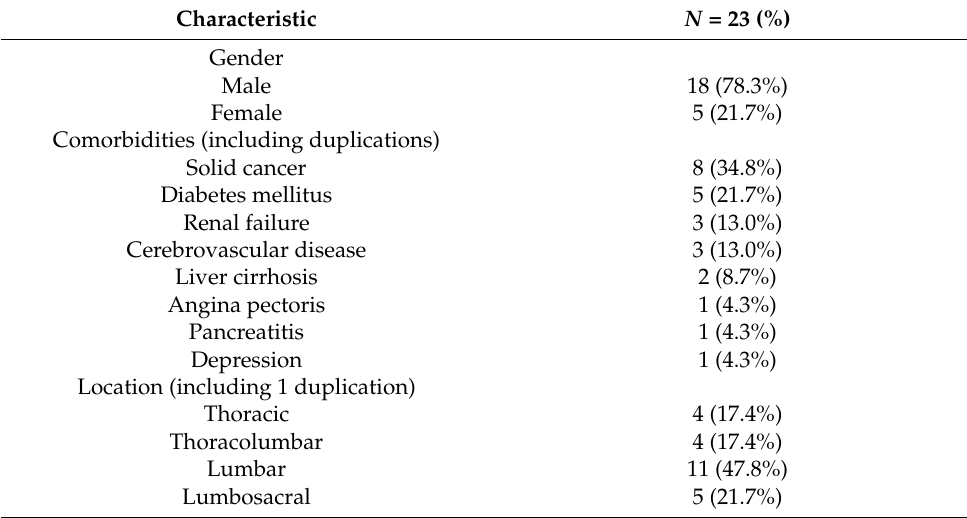
Table 1. Demographic data.